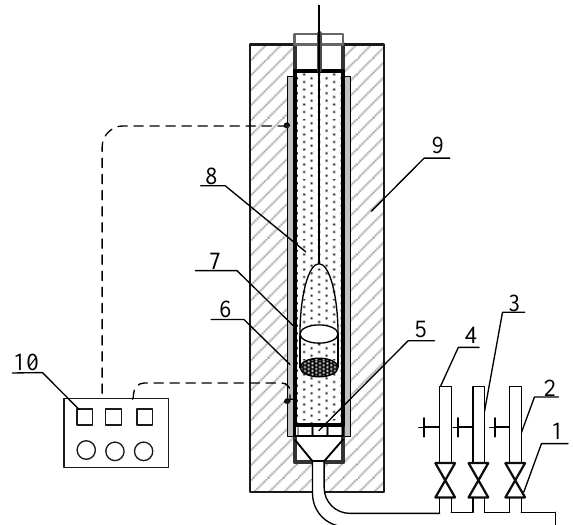
Figure 4. Gas blowing suspension furnace for phosphogypsum decomposition: ( 1 ) glass rotameter; ( 2 ) CO gas; ( 3 ) O 2 gas; ( 4 ) N 2 gas; ( 5 ) air distribution plate; ( 6 ) corundum pipe; ( 7 ) silicon carbon rod; ( 8 ) material box with screen at the bottom; ( 9 ) insulation layer; ( 10 ) automatic temperature control instrument.